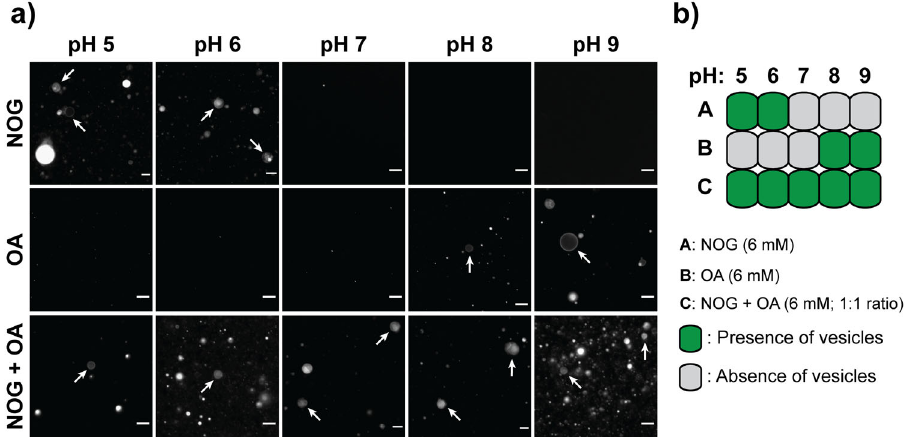
Fig. 3 Vesicle formation behavior of the NOG + OA mixed system. a Fluorescence microscopy shows that 6 mM NOG and 6 mM OA by themselves generate vesicles at pH 5, 6, and pH 8, 9, respectively. However, the NOG + OA mixed system (6 mM total amphiphile; 1:1 ratio) forms vesicles across pH 5 to 9. Vesicles are indicated by white arrows. For fl uorescence-based imaging, vesicles were stained with 10 μ M of an amphiphilic dye named Octadecyl Rhodamine B Chloride (R18). The scale bar is 10 µ m, b Schematic representation of the microscopy results that were shown in a